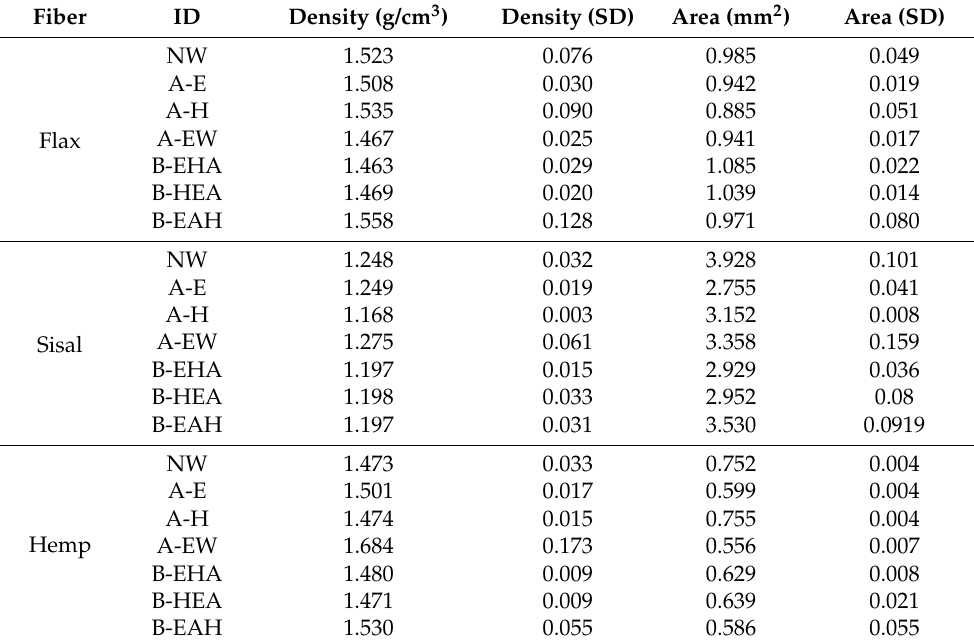
Table 2. Density and area values of the yarns, with standard deviation (SD), before and after washing